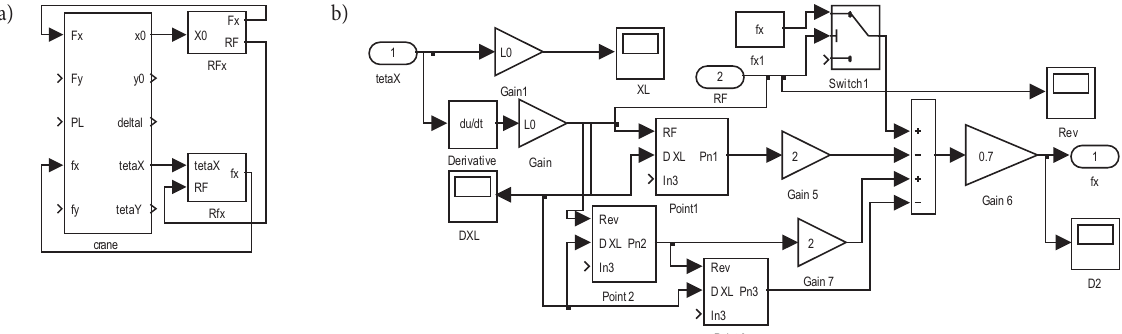
trajectory)Fig. Table. The factual coordinates of the control switching points (Fig. Fig. 9. The cycle of movement of the trolley with a cargo: a – a change of the force generated by the engine, dislocation and velocity; b – the phase trajectory of the trolley (a circle means the start of reversing; a square – the moment of switching-off the engine; the asterisk – the end of the phase